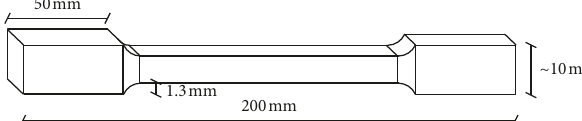
Figure 3: Principal geometry of the milled dog-bone test specimens.